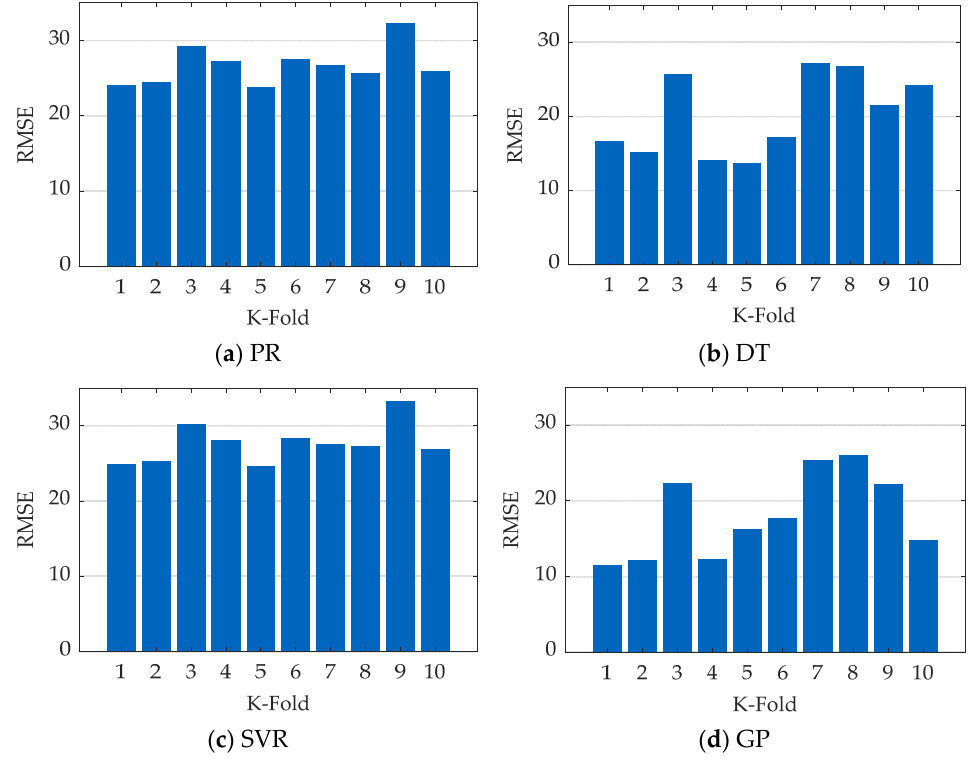
Figure 11. RMSE for 10 ‐ fold cross ‐ validation of the PR, DT, SVR and GP models for Use Case 2.